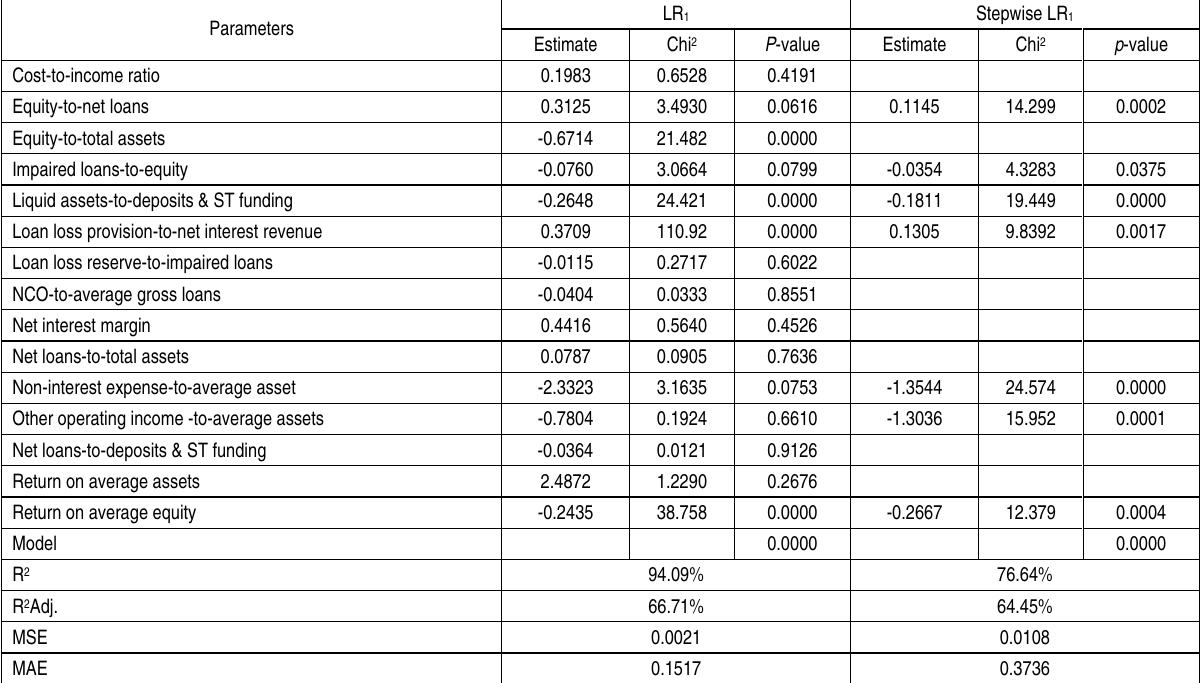
Table 3. Logistic regression analysis result for Model